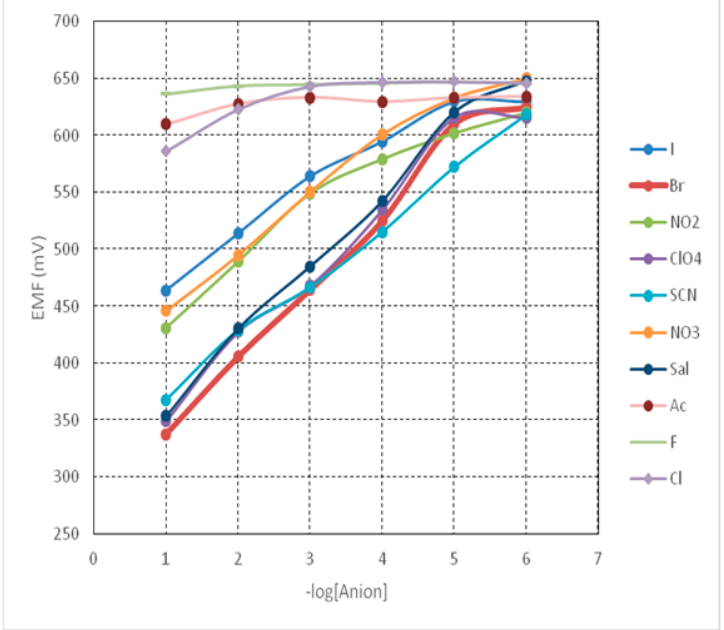
Figure 3. Potentiometric response of sensor B to different anions.